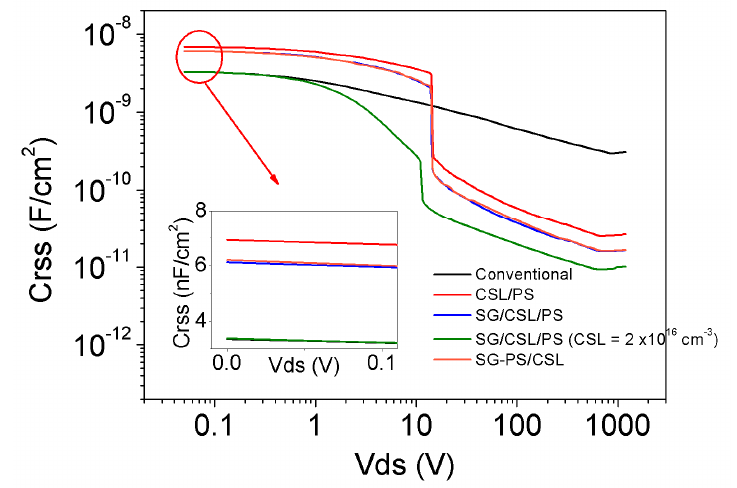
Figure 7. Crss of conventional, CSL/PS, SG–PS/CSL, and SG/CSL/PS, with different CSL doping concentrations. The frequency is at 1 MHz and Vgs is 0 V. If not otherwise specified, the CSL doping concentration is 9 × 10 16 cm − 3 . © (2020) IEEE. Reproduced, with permission, from [14].